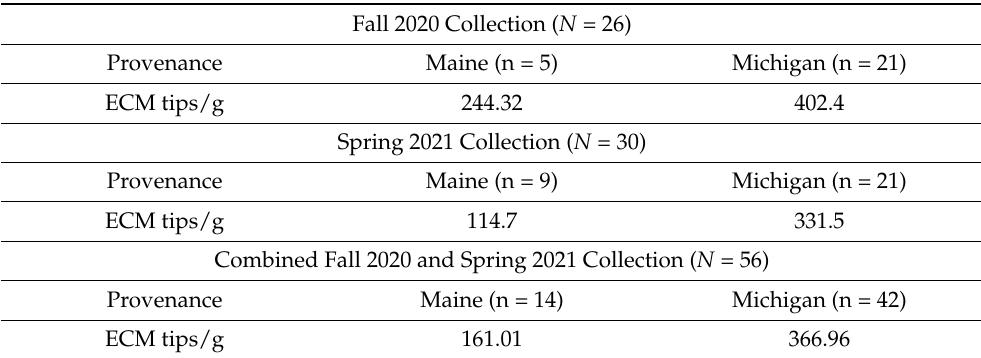
Table 4. Mean abundance of ECM root tips from fall 2020, spring 2021, and combined collections in the different provenances. The total numbers of colonized root tips were standardized per 1 g of dried root biomass. Tree condition was determined by two independent observers. Root tip abundance varied significantly between Maine and Michigan when collections were combined.